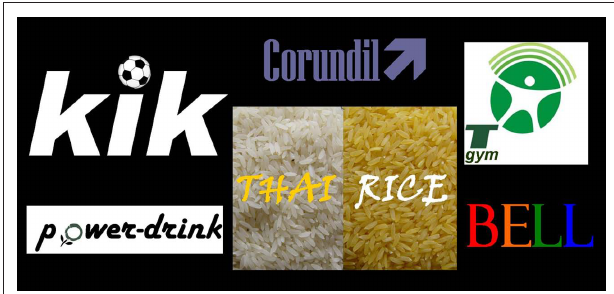
FIguRe 1 | examples of some of the logos used as fictitious